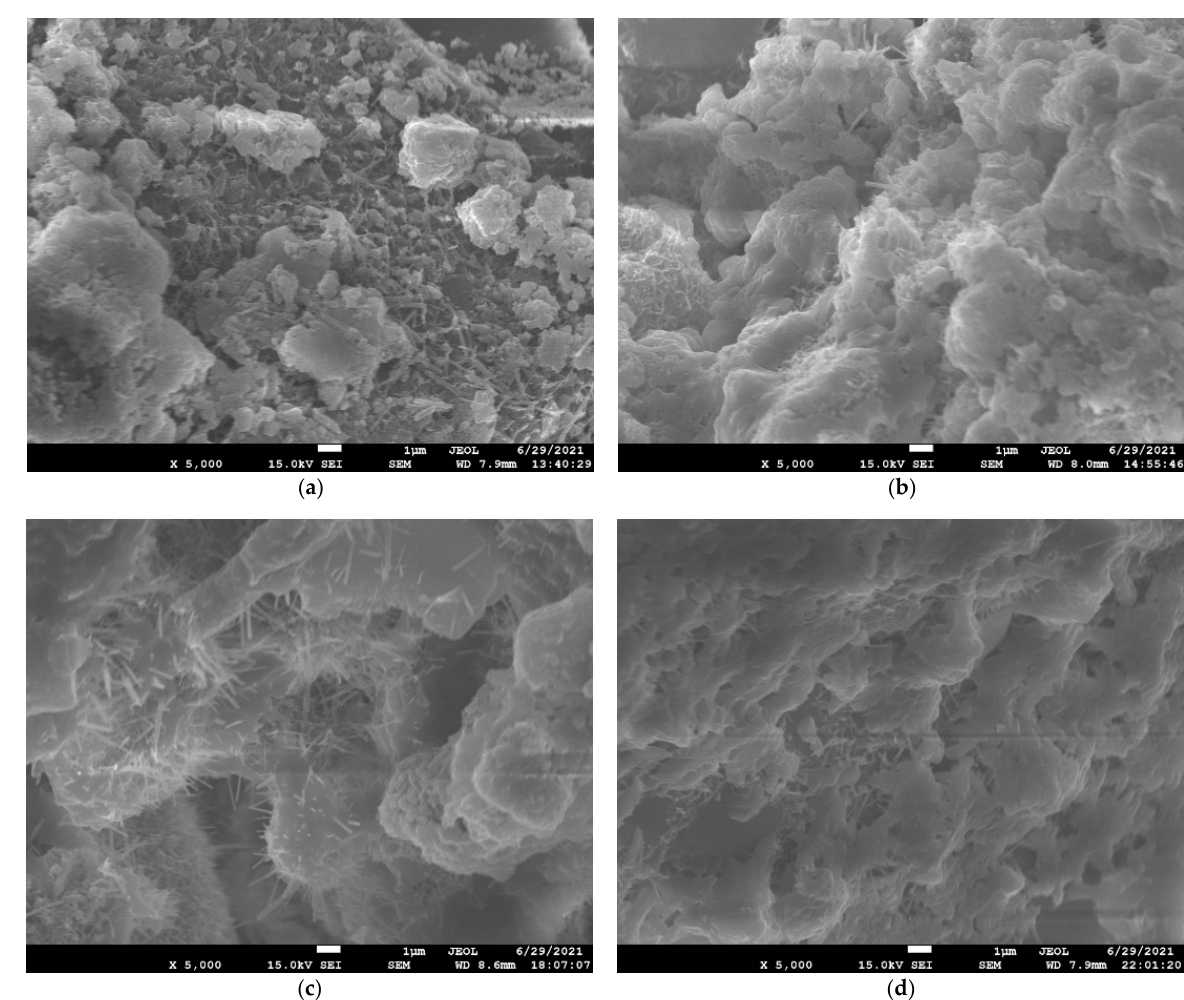
Figure 10. SEM patterns of CSTB in 3 d (( a ) TCR = 4; ( b ) TCR = 12) and 7 d (( c ) TCR = 4; ( d ) TCR = 12) under SC = 72%.